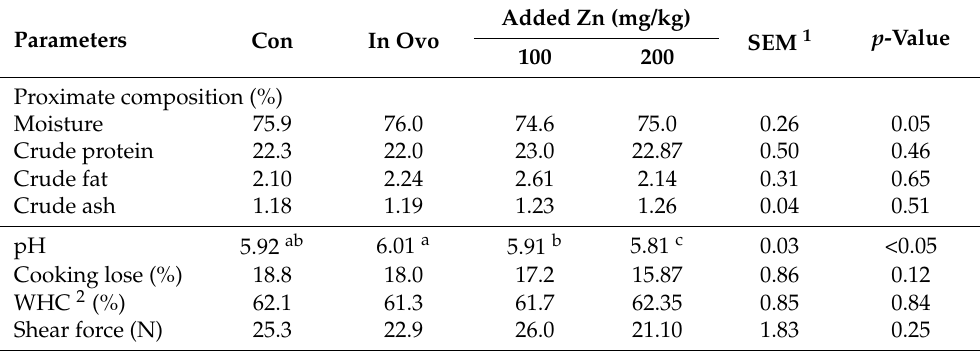
Table 5. Effect of in ovo injected and supplemental Zn breast meat quality in broilers at 35 days of age.